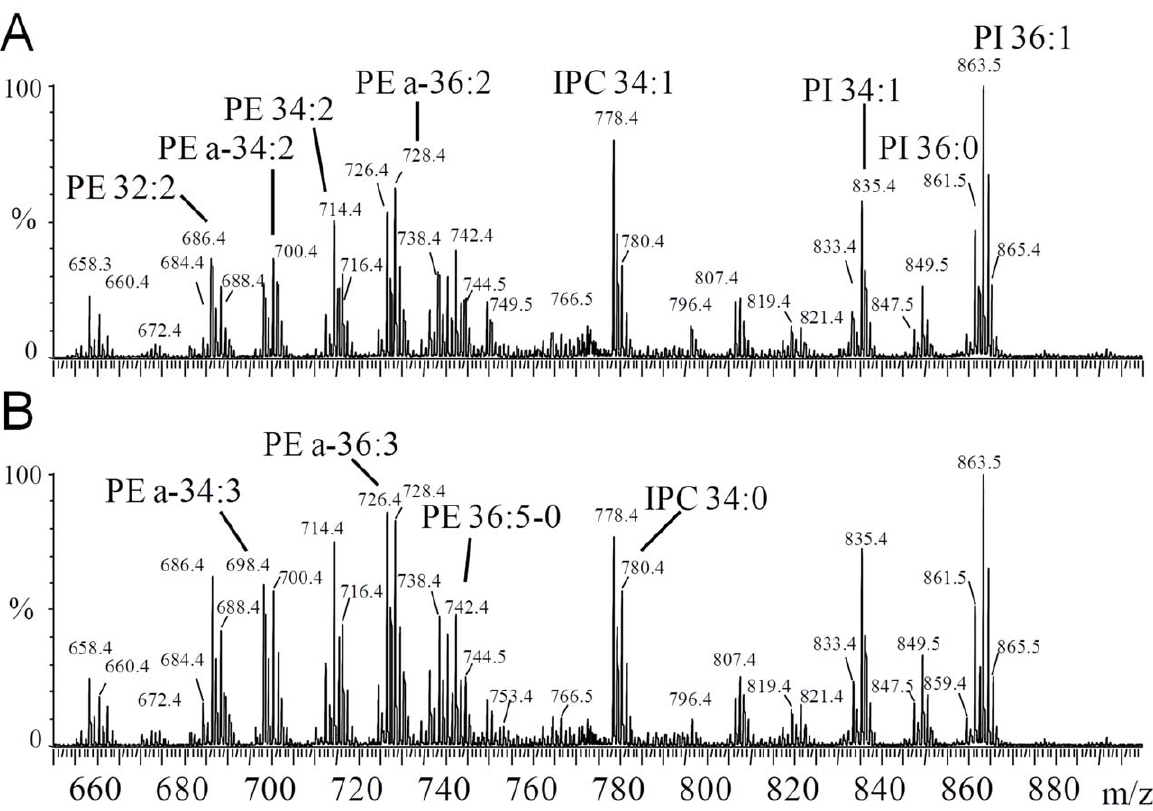
Figure 6. Phospholipid accumulation in D atg5 promastigotes. Negative ion survey scans (650–900 m/z) of WT (A) and D atg5 (B) promastigotes extracted for lipids and analysed by ES-MS, as described in Materials and Methods.